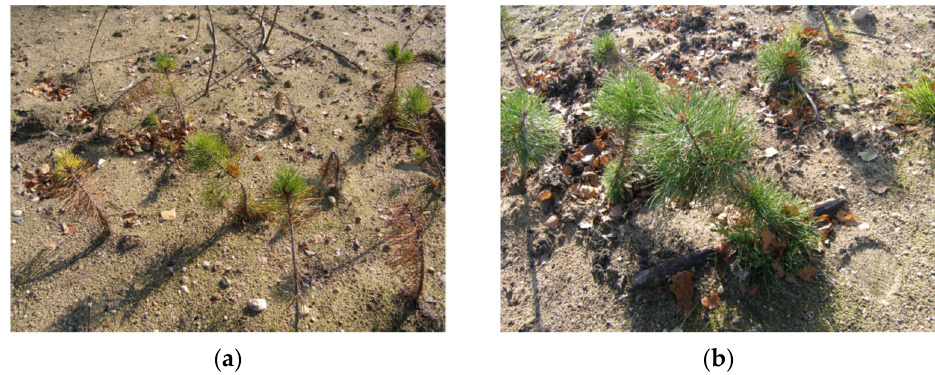
Figure 7. Mycorrhized Scots pine growing in a plot in the field growing on control soil ( a ) and on soil enriched with sewage sludge ( b ), (photo M. Kacprzak).